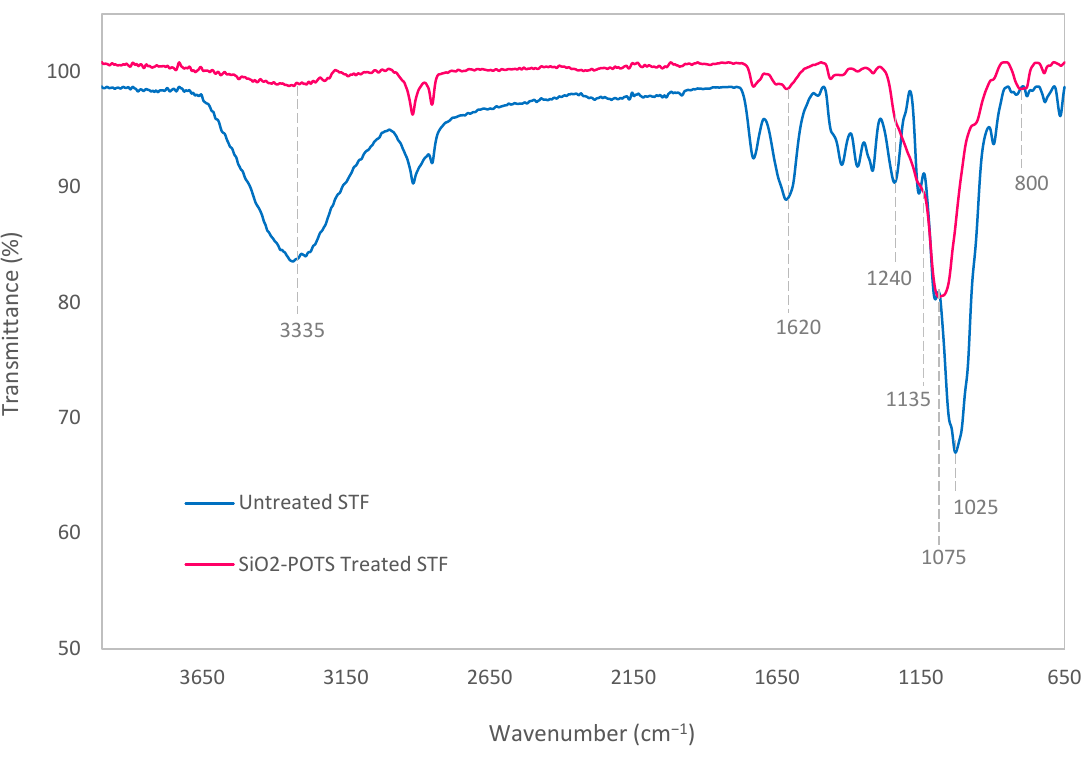
Figure 3. FTIR spectra of untreated and SiO 2 -PFOTS treated STF.